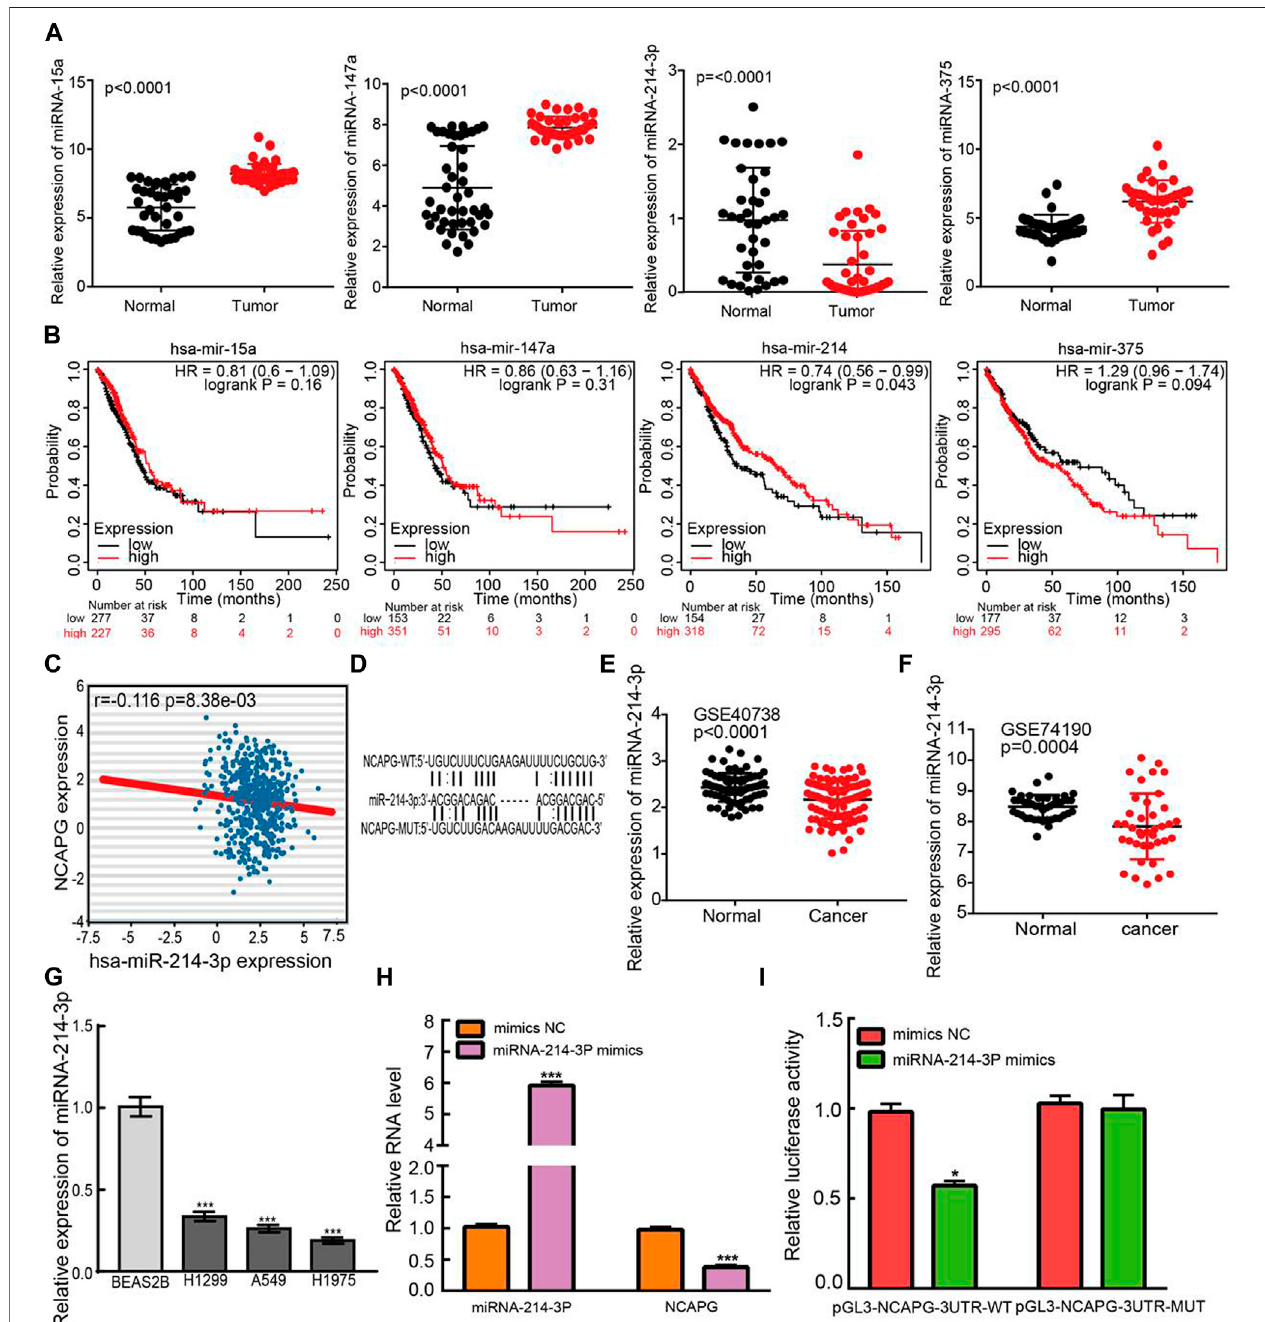
FIGURE 10 | Identi fi cation of upstream miRNAs of NCAPG in LUAD. (A) The expression of miRNA-15a, miRNA-147a, miRNA-375, and miRNA-214-3p in TCGA- LUAD. (B) The prognostic values of miRNA-15a, miRNA-147a, miRNA-375, and miRNA-214-3p in TCGA-LUAD. (C) The correlation between expression of miRNA- 214-3p and NCAPG in LUAD. (D) The potential binding sites of miR-214-3p and NCAPG. (E) The expression of miRNA-214-3p in NSCLC was examined by the GEO database. (F) The expression of miRNA-214-3p in NSCLC determined by GEO database (G) The expression of miRNA-214-3p in NSCLC cell lines. (H) The expressionofNCAPGinA549cellafteroverexpressionofmiRNA-214-3pexaminedbytheqRT-PCRassay. (I) Relativeluciferaseactivitiesofwildtype(WT)andmutated (MUT) NCAPG – 3 ′ UTR reporter plasmid in A549 cells cotransfected with miRNA-214-3p mimics. * p < 0.05, ** p < 0.01, *** p < 0.001.